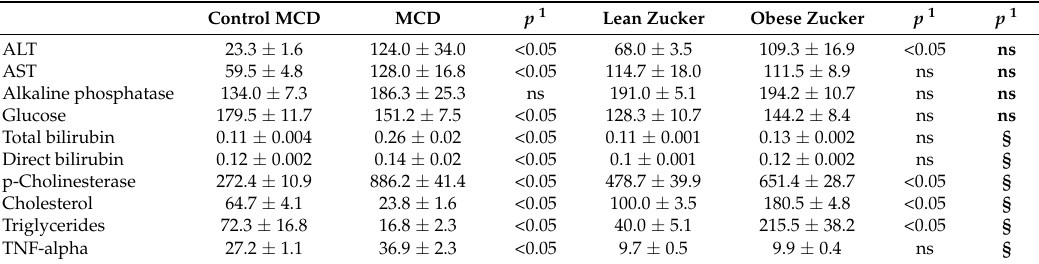
Table 3. Serum parameters in MCD and Obese Zucker